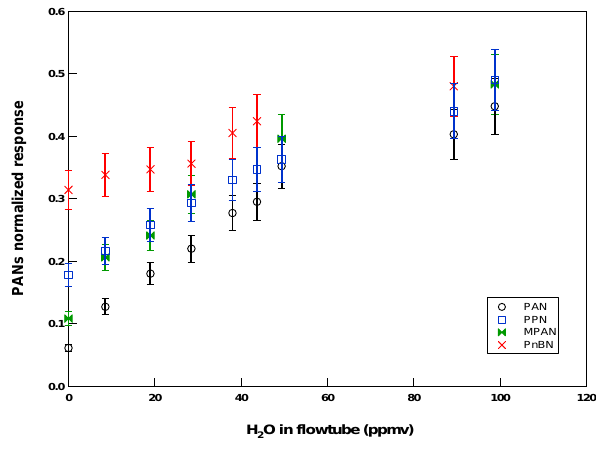
Fig. 14. Ambient NO titration effect on the TD-CIMS signal as the aircraft instrument sampled from a fresh power plant plume.